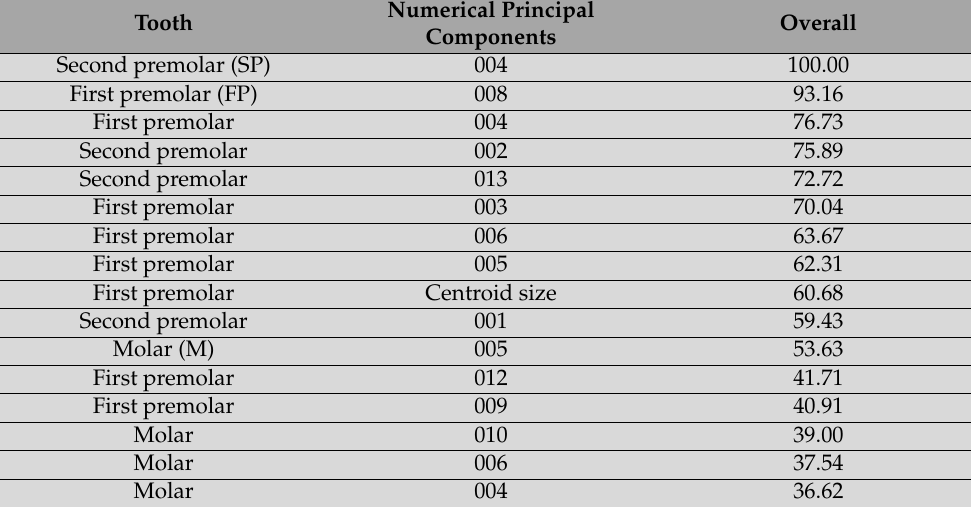
Table 2. Twenty significant principal components of the three different teeth. SP: second premolar; FP: first premolar; cs: centroid size; M: